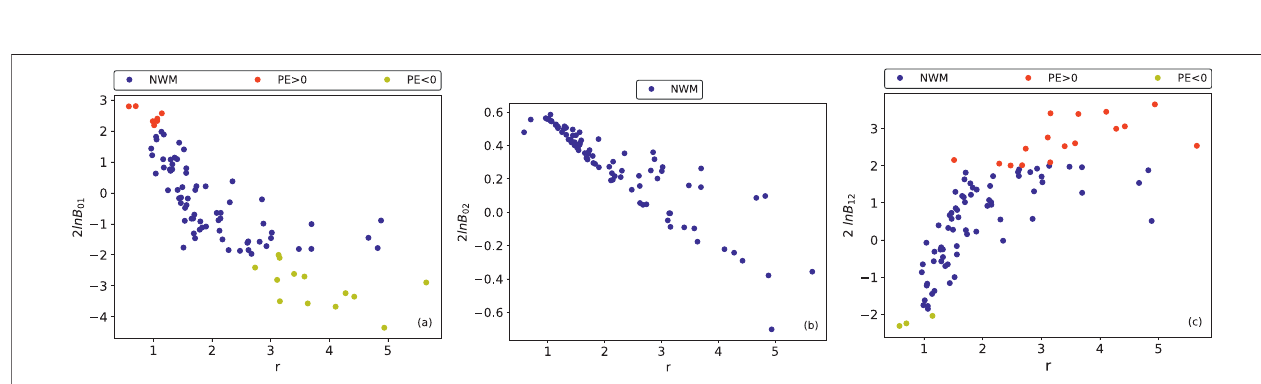
FIGURE 7 | Representation of the Bayes factors computed for the 89 events selected from Verwichte et al. (2013) and Goddard et al. (2016). The different panels correspond to the three one-to-one comparisons between resonant absorption, phase mixing, and wave leakage, here represented with the subscripts 0, 1, and 2 respectively. Adapted from Montes-Solís and Arregui